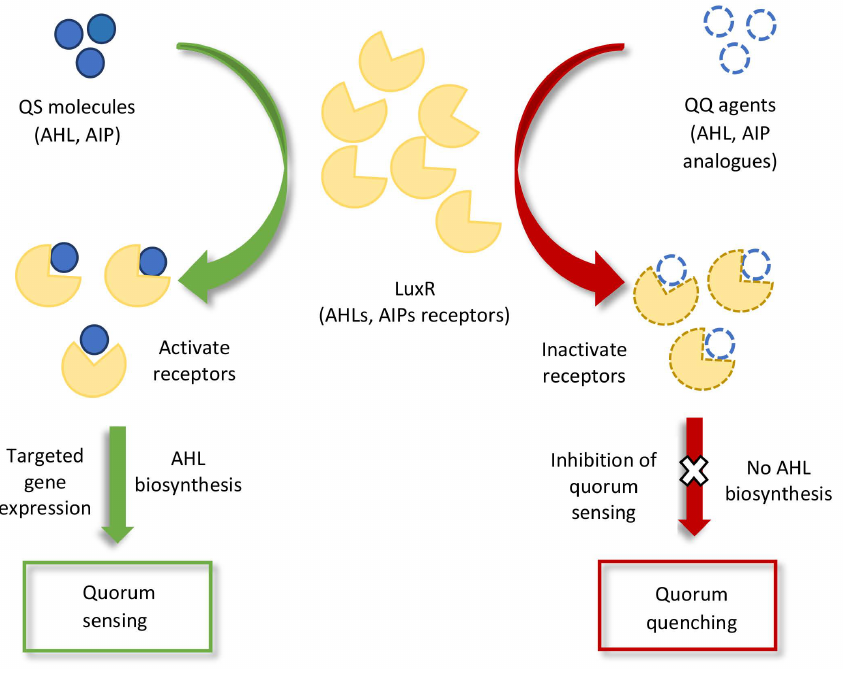
Figure 2. Schematic representation of quorum sensing (QS) and quorum quenching (QQ) inhibition of signal perception pathways. The binding of QQ agents to the LuxR receptors either inactivates quorum sensing receptors or reduces the quantity of receptors in the QS molecules for targeted gene